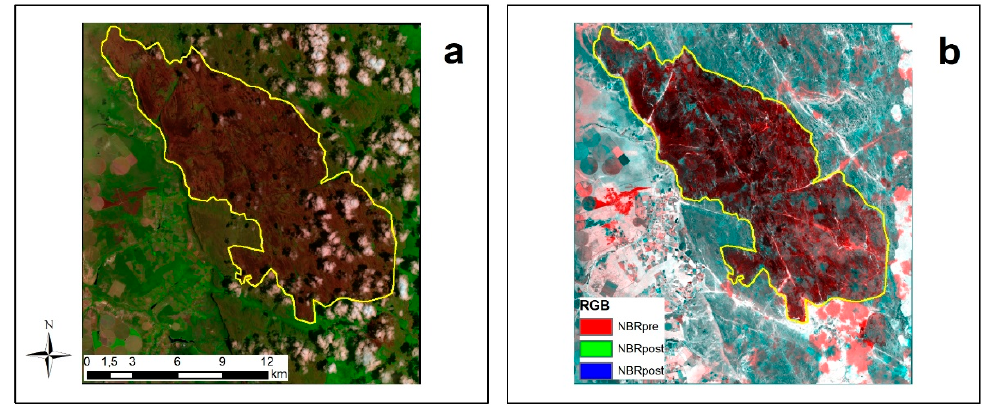
Figure 12. Pictures of: ( a ) colored composition image corresponding to the postfire image for the Gerais do Machobongo fire, data from the Landsat-8 7-5-4 RGB OLI sensor and ( b ) multitemporal visualization of the burnt area in the Gerais do Machobongo fire, NBRpre/NBRpost/NBRpost RGB.